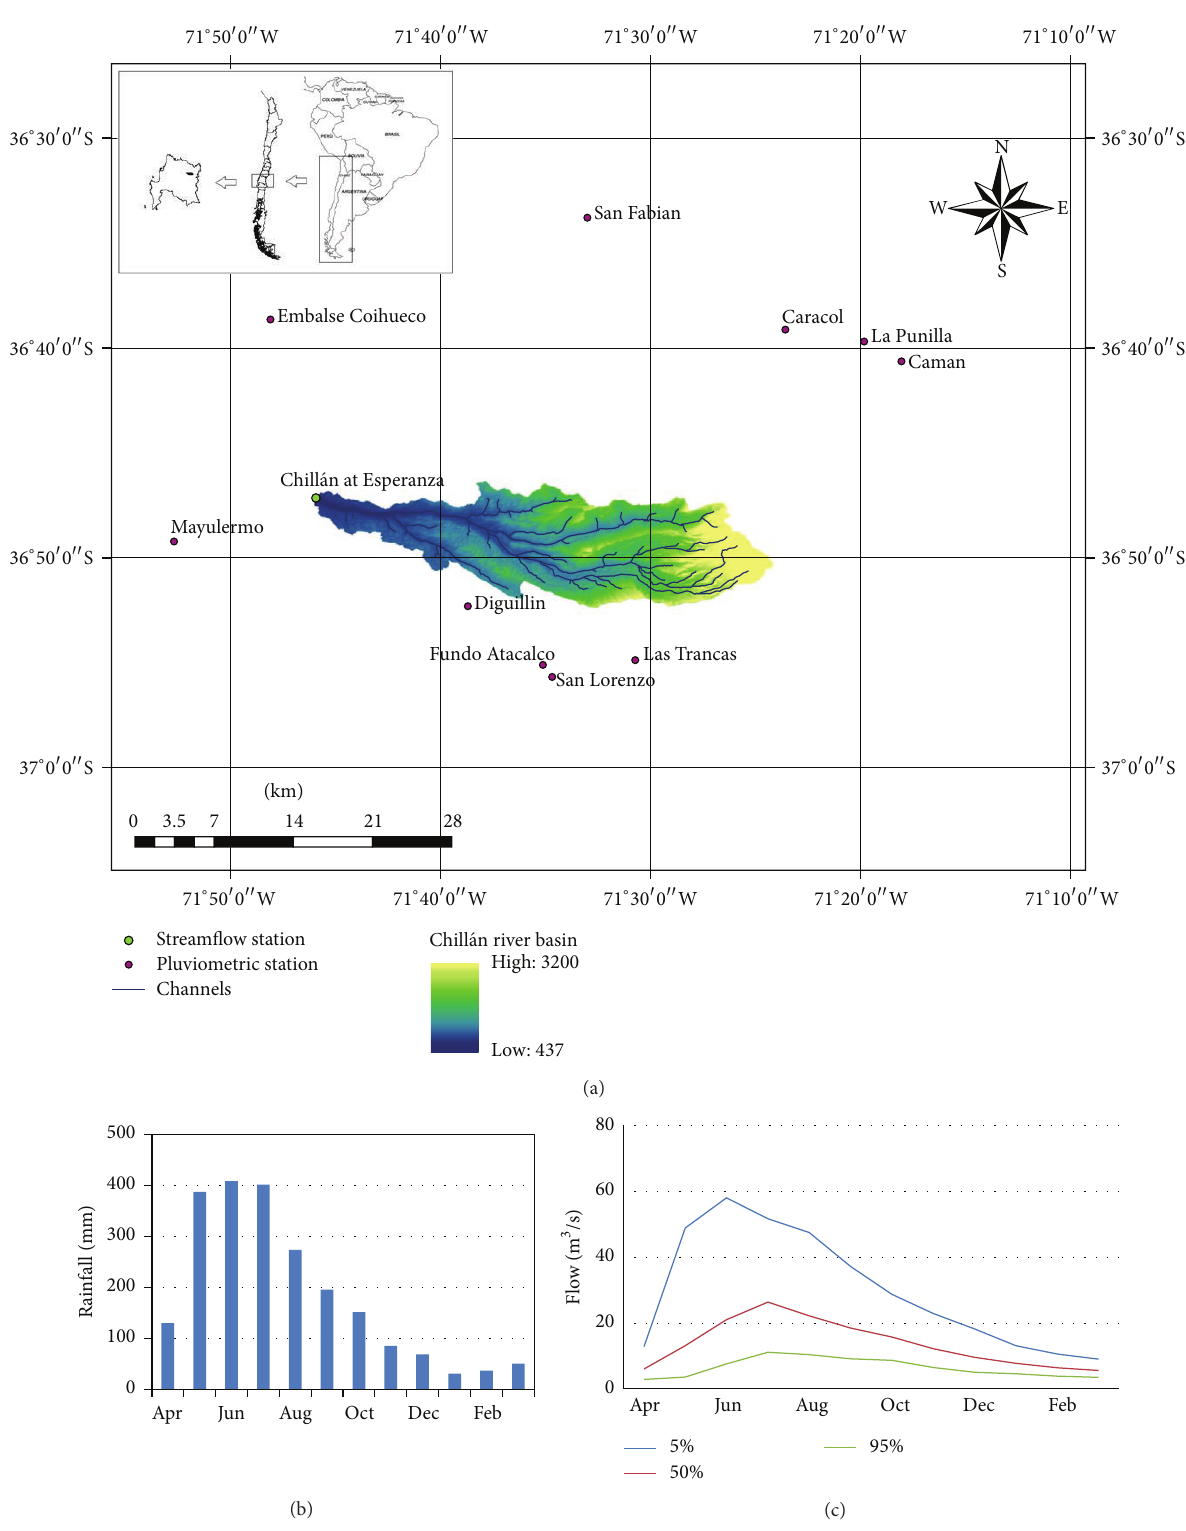
Figure1:Digitalelevationmodelandlocationofthe Chill´anenEsperanza basin(top),seasonalrainfalldistribution(bottomleft),andseasonal variation curves of 5, 50, and 95% exceedance probability of the Chill´an en Esperanza river basin (bottom